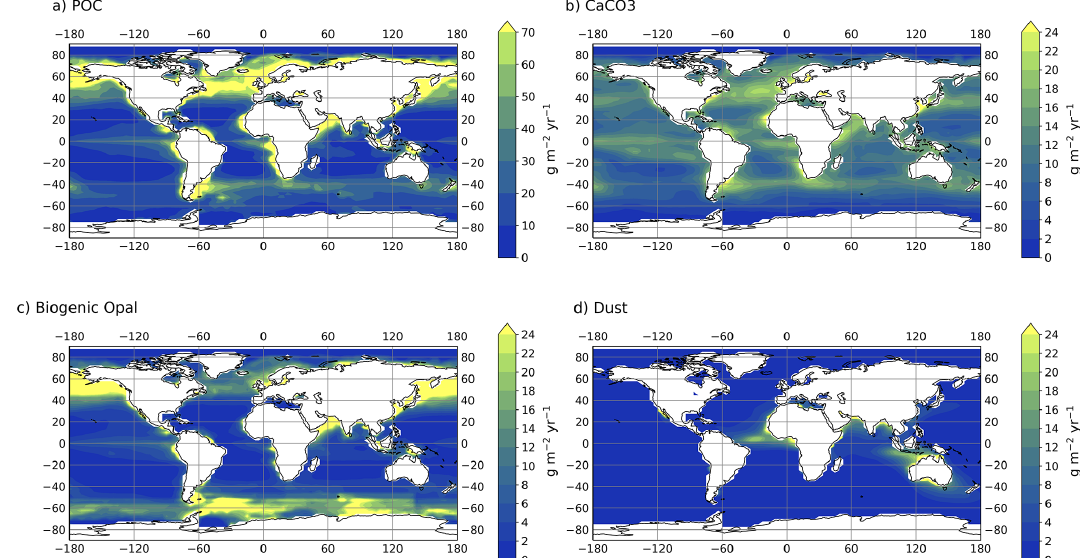
Figure 7. Particle export fields from the ocean surface (gm − 2 yr − 1 ). Biogenic particle fields are prescribed using satellite-derived export productivity fields for (a) POC, (b) CaCO 3 , and (c) opal (Dunne et al., 2007, 2012). The dust input fields (d) are annual mean dust deposition simulated for the pre-industrial era by the HadGEM2-A GCM (Hopcroft et al., 2015). Note the different scale used for panel (a) . Table 2. Global mean particle concentrations for each particle type used to calculate equilibrium scavenging coefficients following Eq. (15). In summary, export fluxes of POC, CaCO 3 , and opal in this study are from Dunne et al. (2007, 2012), while dust fluxes are from Hopcroft et al. (2015). Global mean particle concentrations reported in previous Nd isotope schemes are shown for